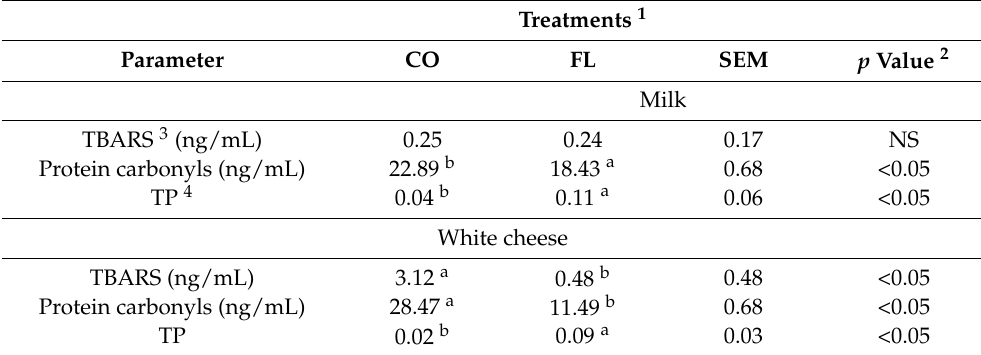
Table 7. Effects of dietary supplementation of flaxseed and lupin seed on antioxidant status of milk and white